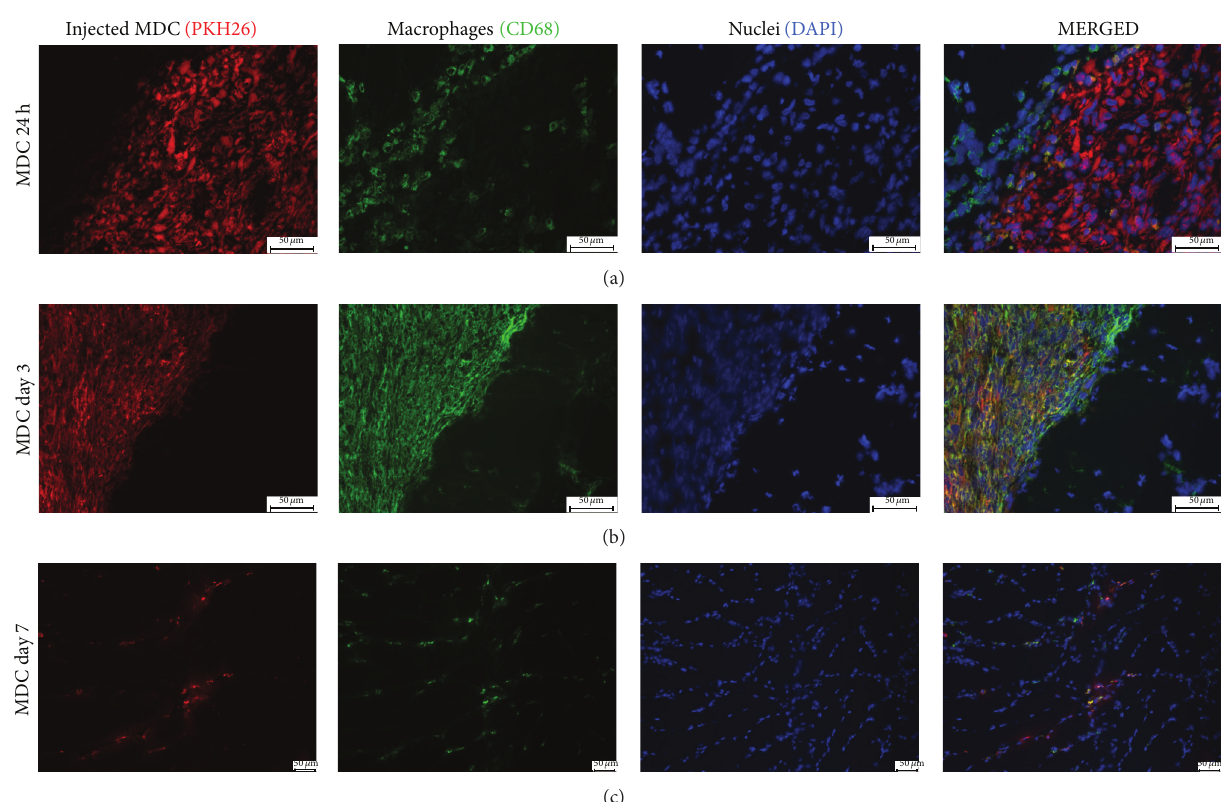
Figure4:Immunohistochemicalstainingindifferenttimepoints.Macrophages(CD68antigenstainedwithAlexa488(green))areinfiltrating the cluster of transplanted MDC (PKH26 (red)). Cell nuclei stained with DAPI (blue). Scale bars: 50 𝜇